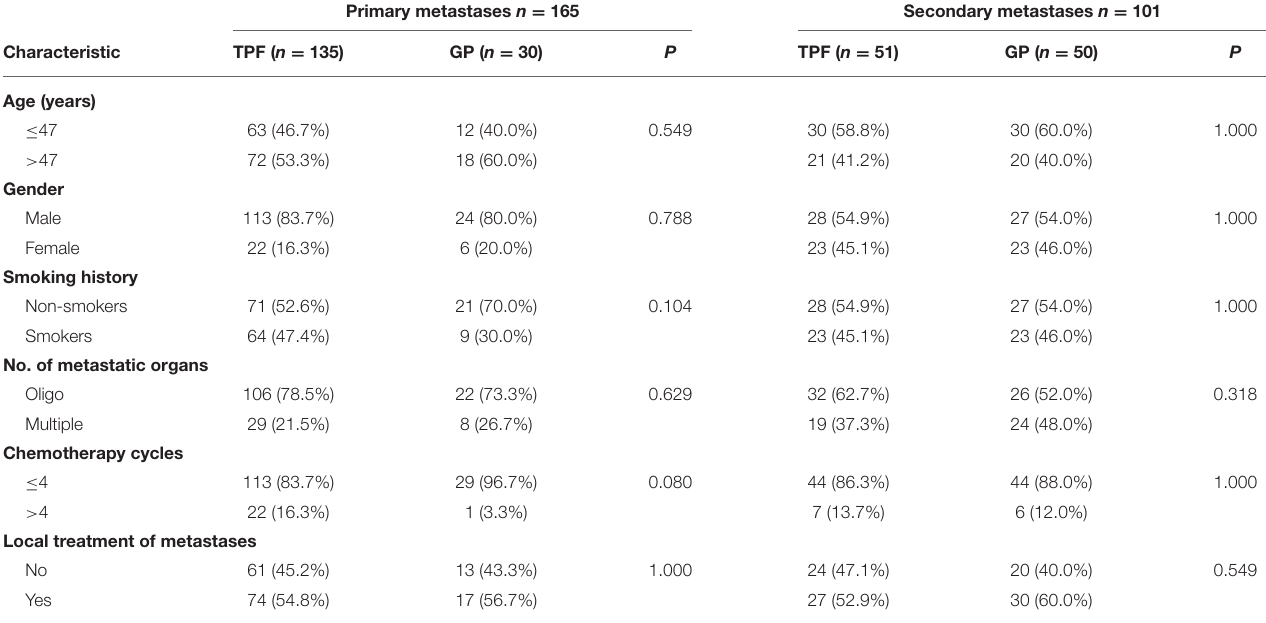
TABLE 3 | Clinical characteristics of patients in primary/secondary metastases subgroups. Primary metastases n = 165